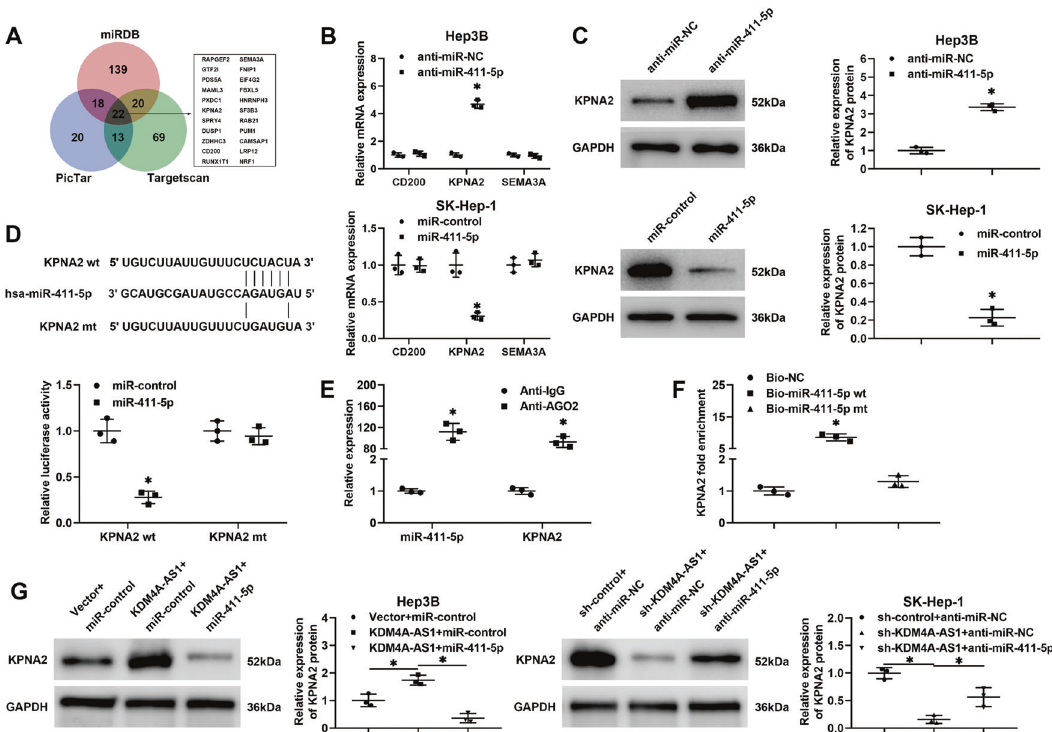
Fig. 6 KPNA2 is a direct target of miR-411-5p in HCC cells. A Twenty-two potential targets of miR-411-5p were predicted in all three online bioinformatics tools. B miR-411-5p inversely regulated KPNA2 mRNA level rather than CD200 and SEMA3A in HCC cells. C miR-411-5p silencing upregulated and miR-411-5p overexpression increased KPNA2 protein level in HCC cells. D Complementary sequences between miR- 411-5p and KPNA2 3 ’ UTR were mutated, and HEK293T cells co-transfected with miR-411-5p mimics and wt or mt KPNA2 3 ’ UTR was detected for luciferase activity. E Hep3B cells transfected with miR-411-5p mimics were subjected to anti-AGO2 RIP to detect RNAs associated with AGO2. F KPNA2 mRNA level was determined in samples pulled down by biotinylated wt or mt miR-411-5p. G Western blotting was performed to detect KPNA2 expression in HCC cells transfected with the indicating vectors. All the data are presented as mean ± SD of at least three independent experiments. * P <